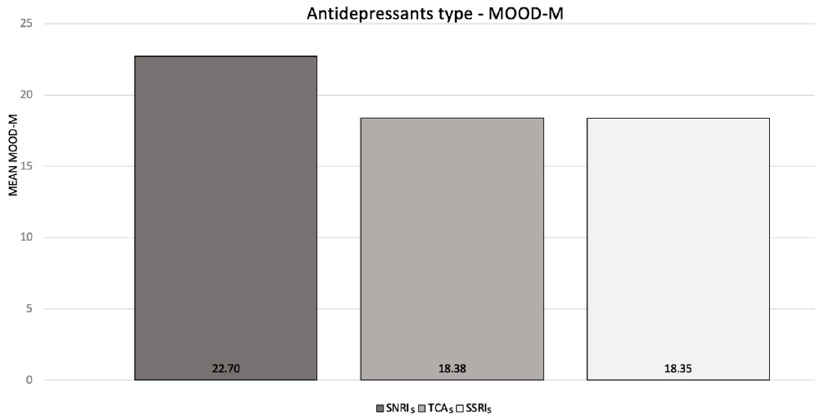
Figure 3. Antidepressant treatments (SNRIs, TCAs and SSRIs) and median MOOD-SR maniac com- ponent values. SNRIs, serotonin noradrenaline reuptake inhibitors; TCAs, tricyclic antidepressants; SSRIs, selective serotonin reuptake inhibitors.